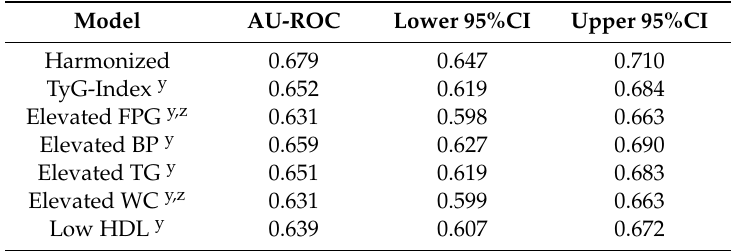
Table 4. AUC comparison of models for 5-year risk of having ≥ 1 MetS